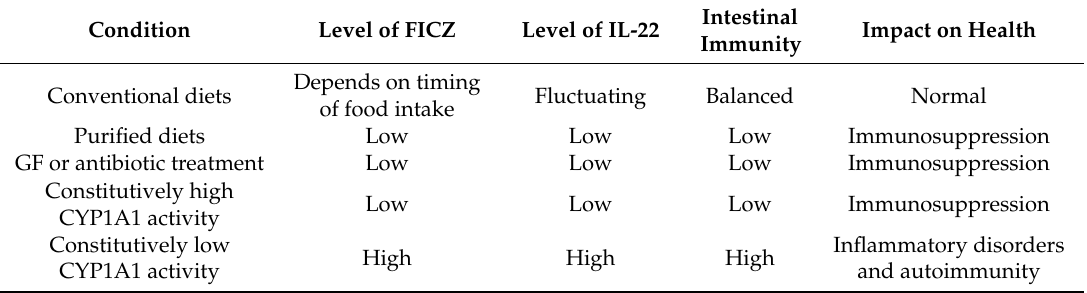
Table 1. The potential influence of various conditions that regulate the level of CYP1A1 activity on the levels of FICZ and immunity in the